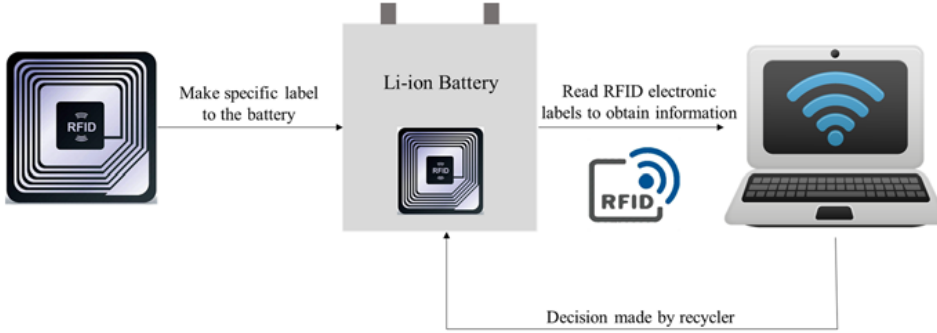
Figure 5. Illustration of RFID labeled LIB cell for information tracking. Blockchain technology is also integrated with IoT to store battery information